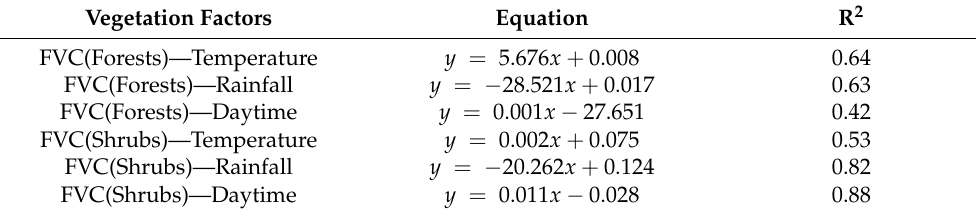
Table 7. Regression analysis of vegetation regeneration and post-fire climate factors.